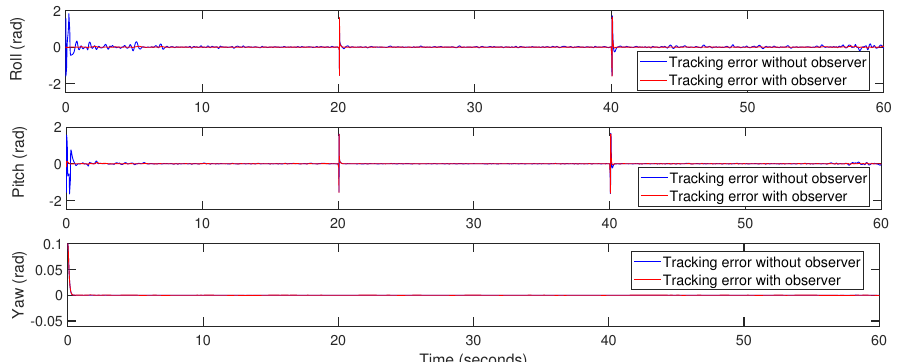
Figure 26. Attitude tracking error when Von Karman wind turbulence model is applied to the attitude subsystem.